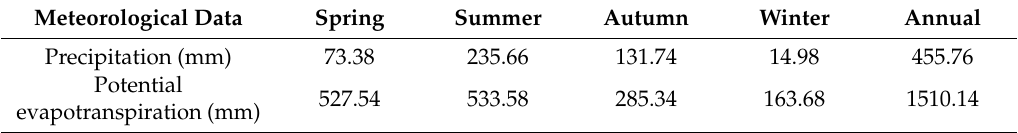
Table 1. Seasonal values of precipitation and potential evapotranspiration in the study area.